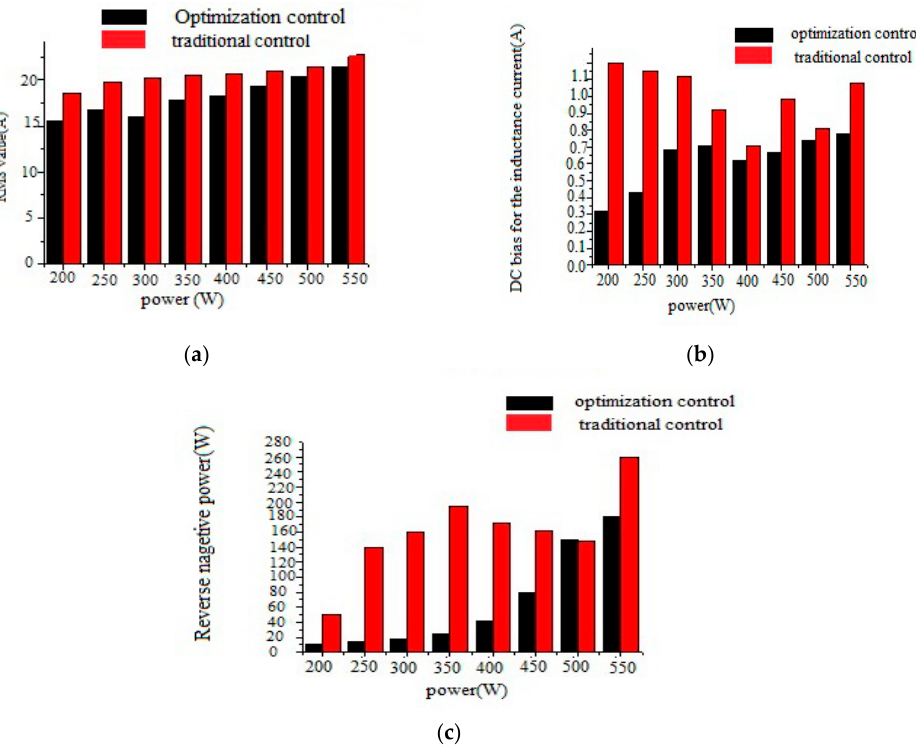
Figure 21. Experimental result for comparison between the optimization control and traditional control methods ( a ) RMS value of inductance current ( b ) DC bias for transformer current ( c ) Reverse negative power.